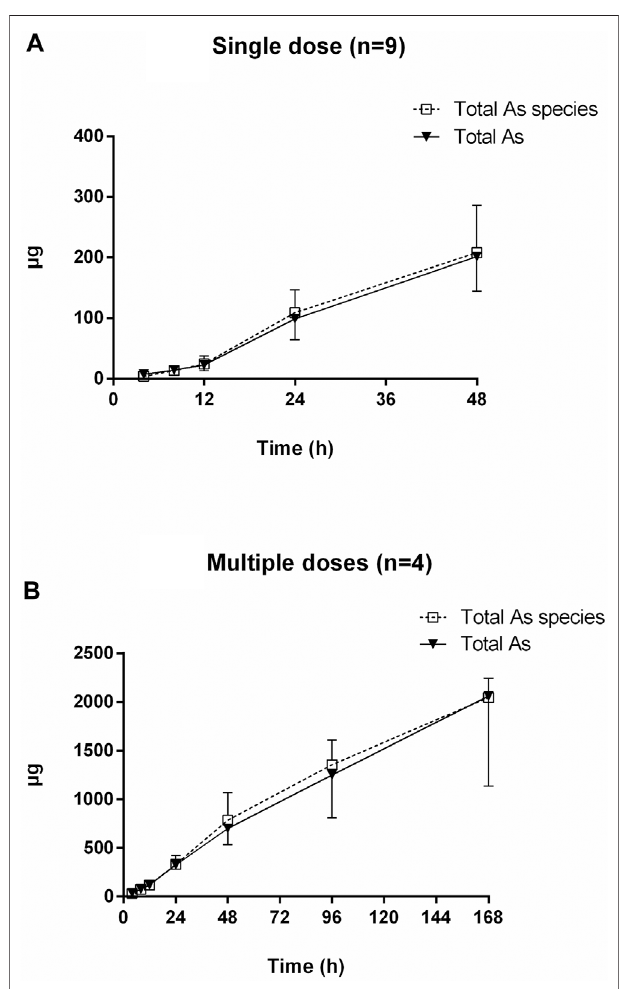
FIGURE 6 | Cumulative excretion of total arsenic and total arsenic species after oral administration of NHJDT. (A) . single dose ( n (cid:1) 9); (B) . multiple doses ( n (cid:1)